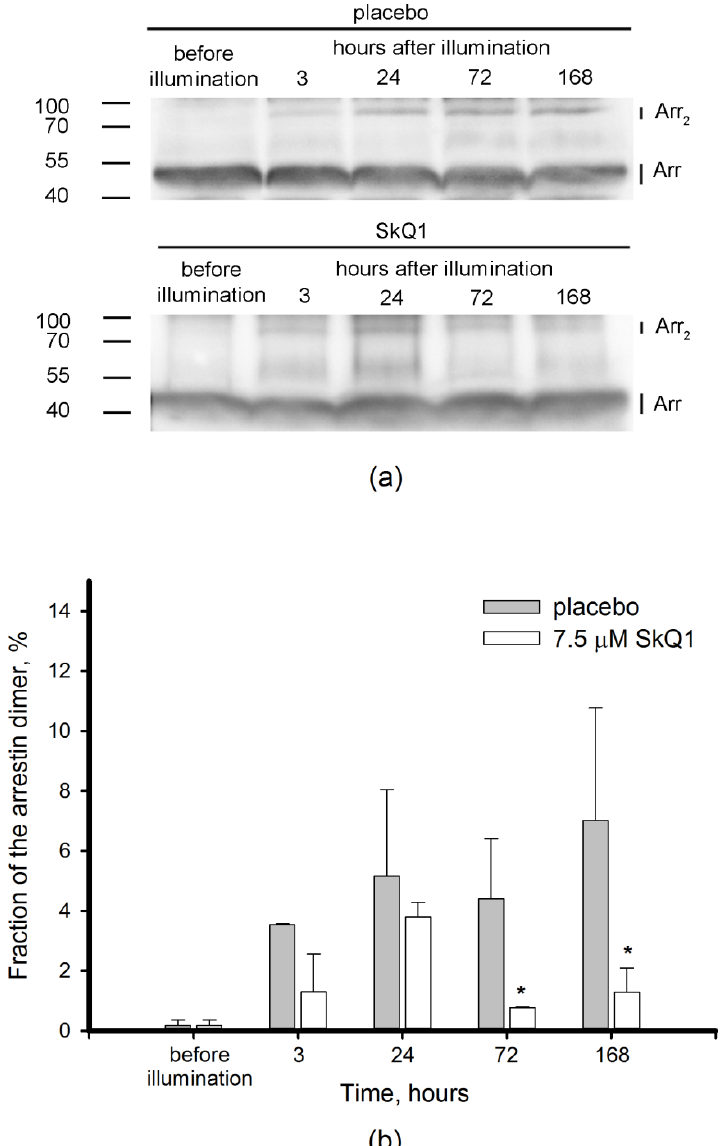
Figure 6. Monitoring of visual arrestin forms in extracts of intact and illuminated rabbit retinas with or without premedication with 7.5 μM SkQ1. ( a ) Western blotting of retinal extracts (normalized by total protein content) under non-reducing conditions using anti-visual arrestin antibodies; ( b ) weight fractions of disulfide dimers of arrestin determined from the Western blotting data. Each bar represents the data obtained from three animals (6 eyes). * p ≤ 0.05 compared with the values measured in the control animals.